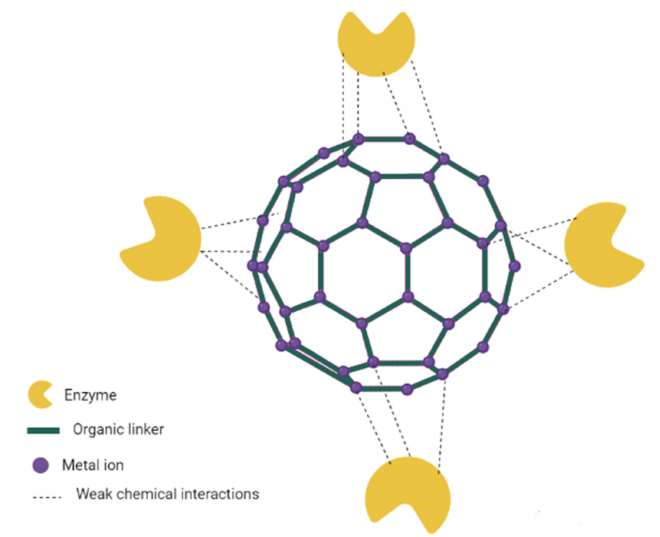
Figure 6. Schematic representation of the physical adsorption of enzymes in